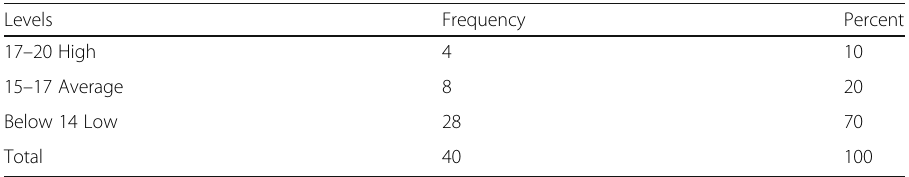
Table 2 Participants ’ classification based on achievement Levels